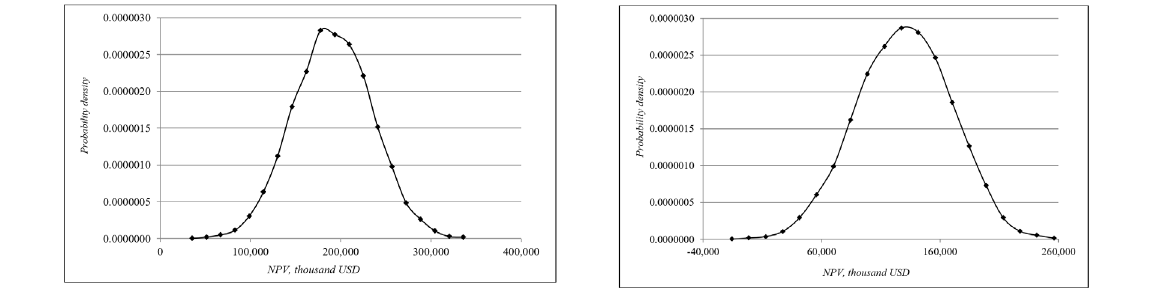
Fig. 6. The probability density function of the NPV of the static optimal investment portfolio